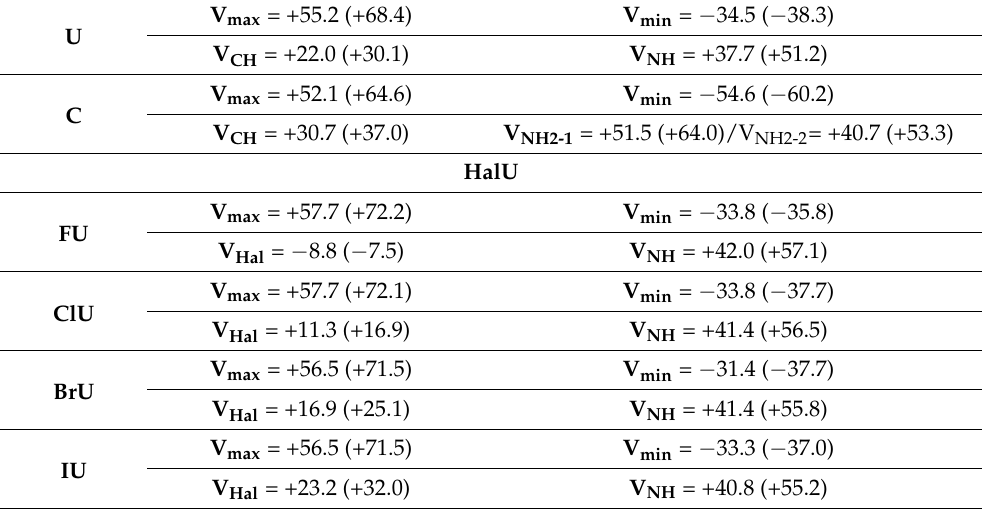
Table 1. Molecular Electrostatic Potential values of the halogen bond and hydrogen bond donor groups (V Hal , V CH , V NH , V NH2-1 , and V NH2-2 , in kcal/mol). These were calculated over the Halogen and H atoms belonging to the C–Hal, C–H and N–H bonds (see the white asterisks in Figure 3 to locate the specific position where the MEP was computed) involving non-halogenated and halogenated Uracil and Cytosine nucleobases at 0.001 a.u. Values in parenthesis correspond to an isovalue contour of 0.002 a.u. (also in kcal/mol). The MEP maxima (V max ) and minima (V min ) values for each nucleobase are also indicated in